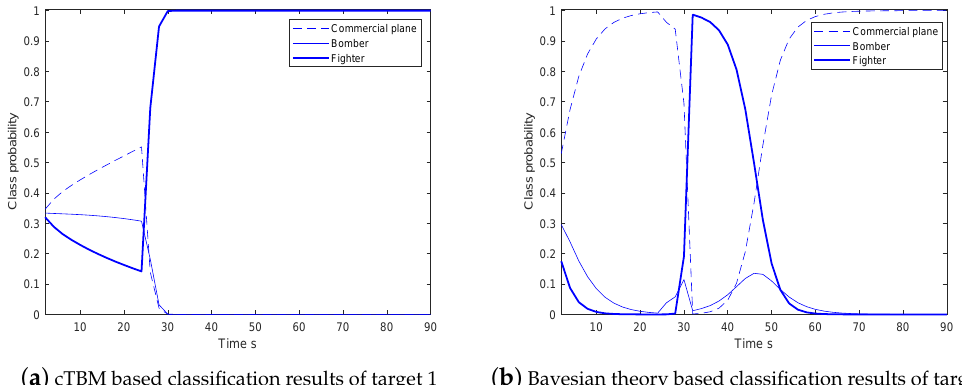
Figure 6. The comparison of the classification results of target 1; ( a ) continuous transferable belief model (cTBM), ( b ) Bayesian theory.